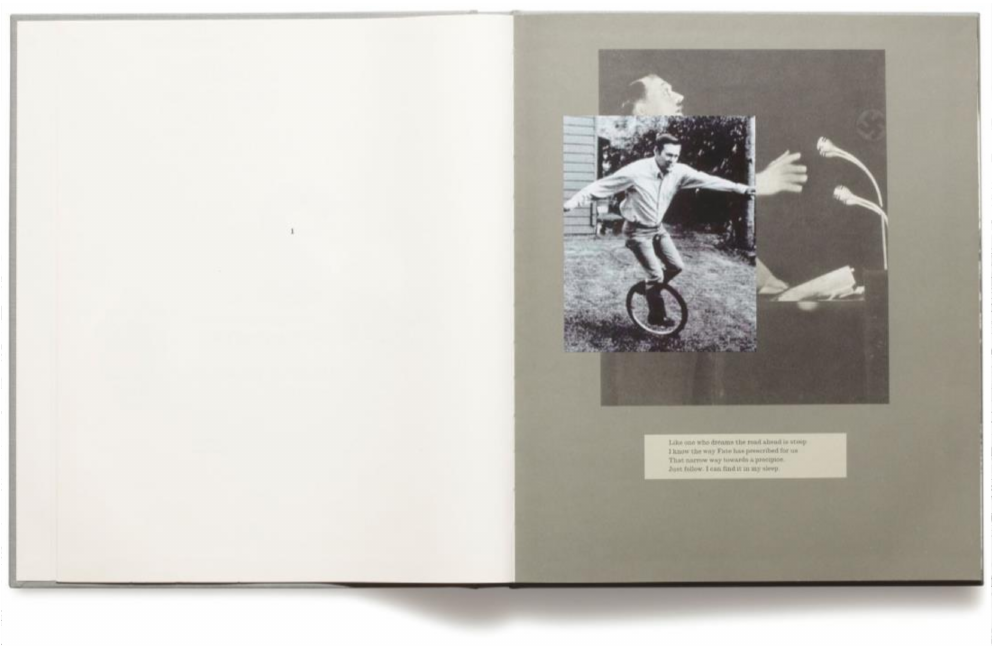
Figure 9. Plate 1. Broomberg & Chanarin. 2011. War Primer